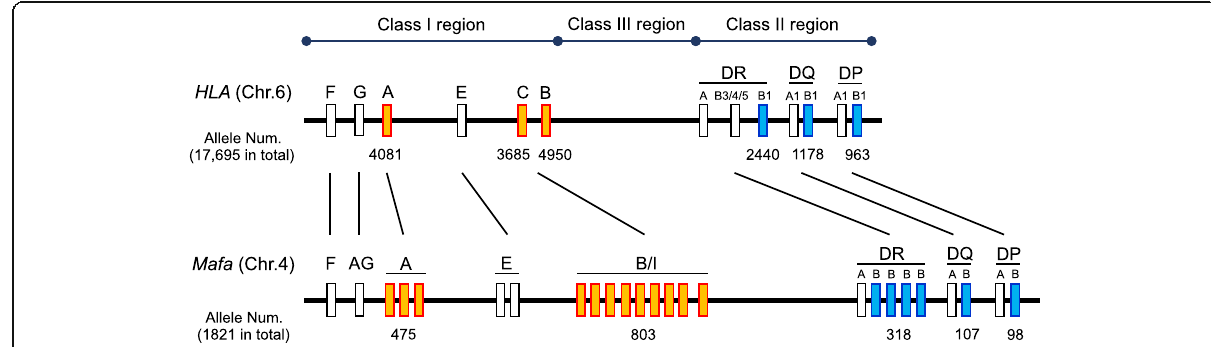
Fig. 2 Comparative genome maps of representative MHC genes in humans and cynomolgus macaques. HLA and Mafa mean human and cynomolgus macaque MHCs, respectively. Orange boxes indicate classical class I genes, HLA-A, HLA-B, HLA-C and their Mafa orthologs ( Mafa-A, Mafa-B and Mafa-I ), in the class I sub-region, and blue boxes indicate classical class II genes, HLA-DR, HLA-DQ, HLA-DP and their Mafa orthologs ( Mafa-DR, Mafa-DQ and Mafa-DP ), in the class II sub-region. Numbers under boxes and in parentheses indicate allele numbers reported by the IPD-IMGT/HLA database release 3.31.0 in January 2018 in humans (Available from: https://www.ebi.ac.uk/ipd/imgt/hla/) and the IPD-MHC database release 3.0.0.1 in February 2018 in cynomolgus macaques (Available from: